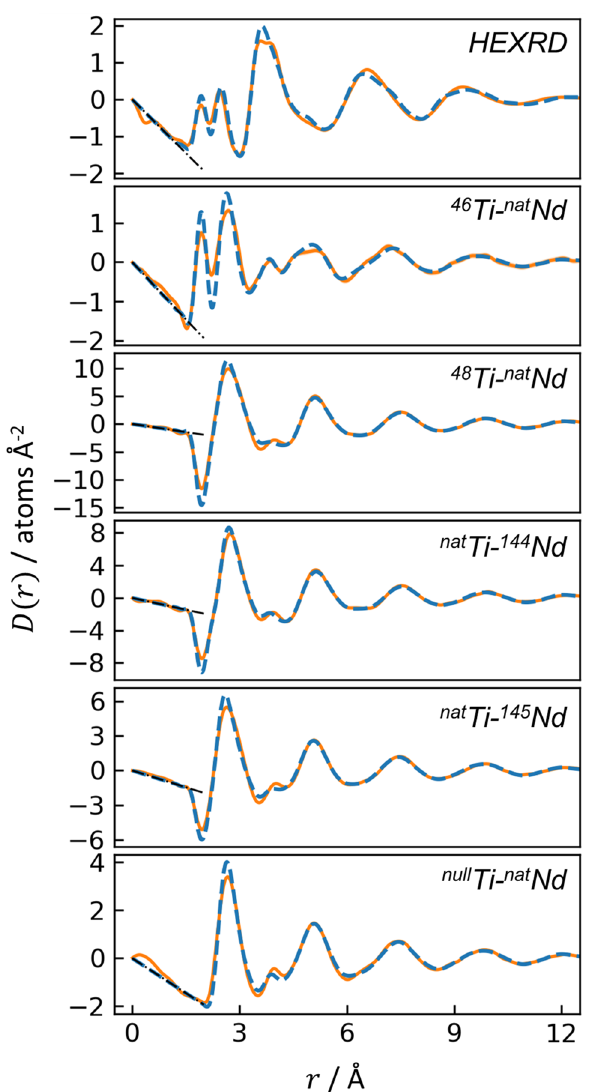
Figure 3. Differential PDFs for the HEXRD and five ND measurements. Solid orange curves are the experimental data, for which the uncertainty arising from diffraction measurements is imperceptibly small; dashed blue curves are the EPSR simulation. Dashed black lines indicate the initial slope given by − 4 πρ